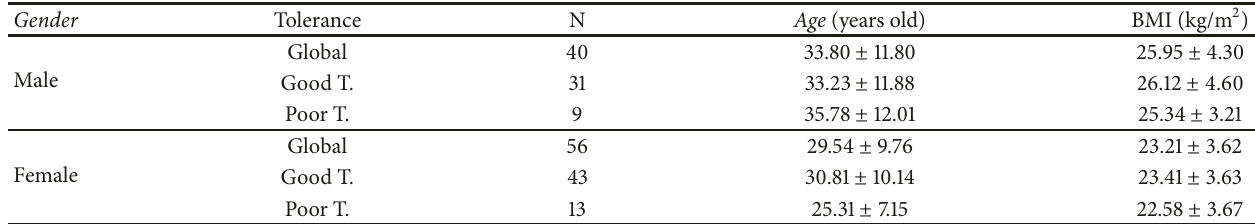
Table 2: Distribution of age and body mass index of the participants by gender and physiological tolerance. Gender